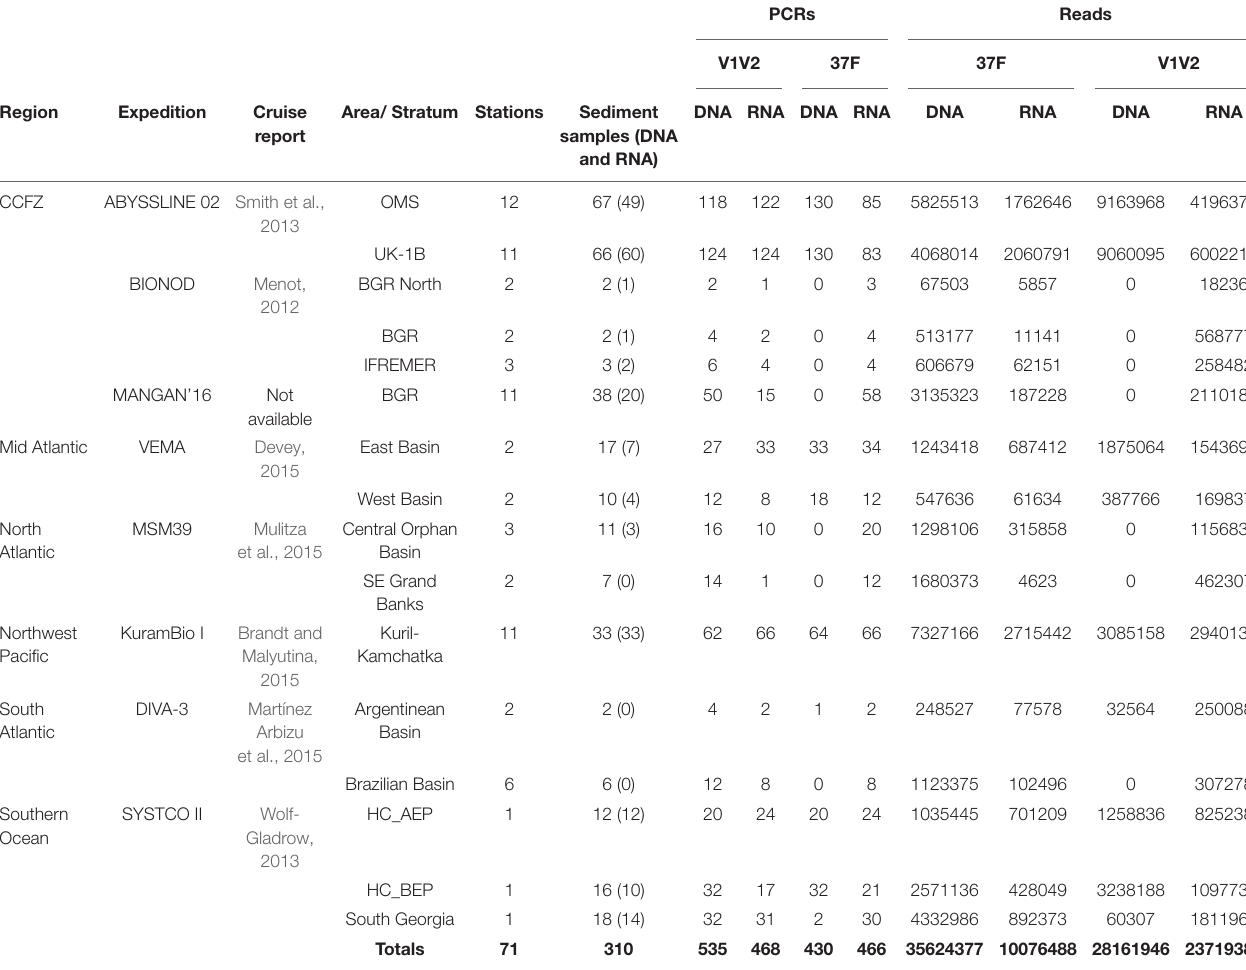
TABLE 1 | Origins and numbers of deep-sea sediment material, and successfully PCR-amplified and sequenced samples.